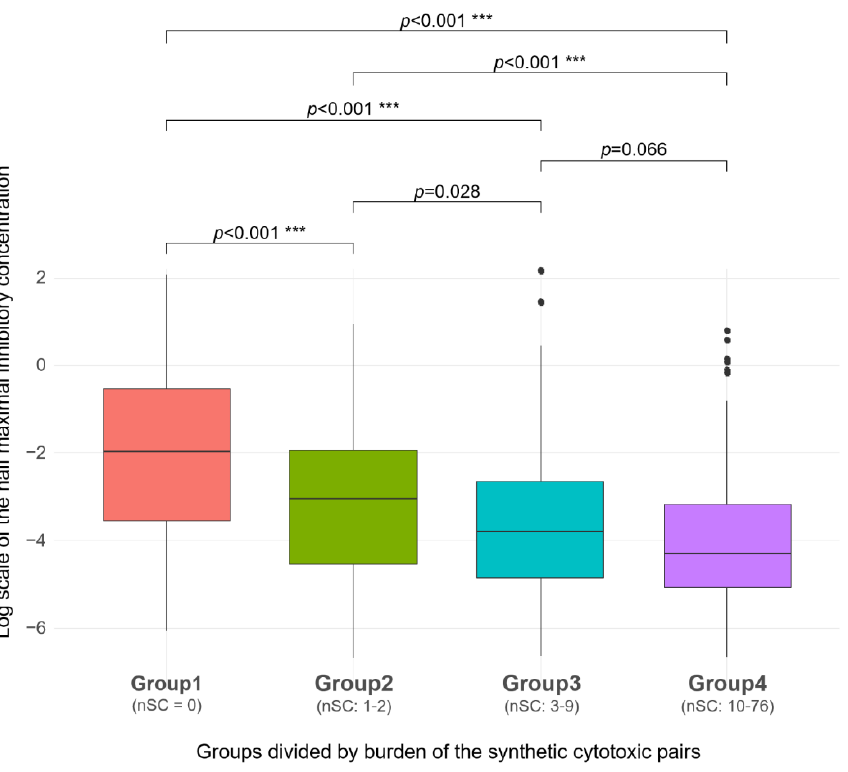
Figure 4. In the four groups divided according to the number of synthetic cytotoxic pairs, groups with more pairs had lower IC 50 values. There were 112, 103, 86, and 106 samples in Group 1 to Group 4,